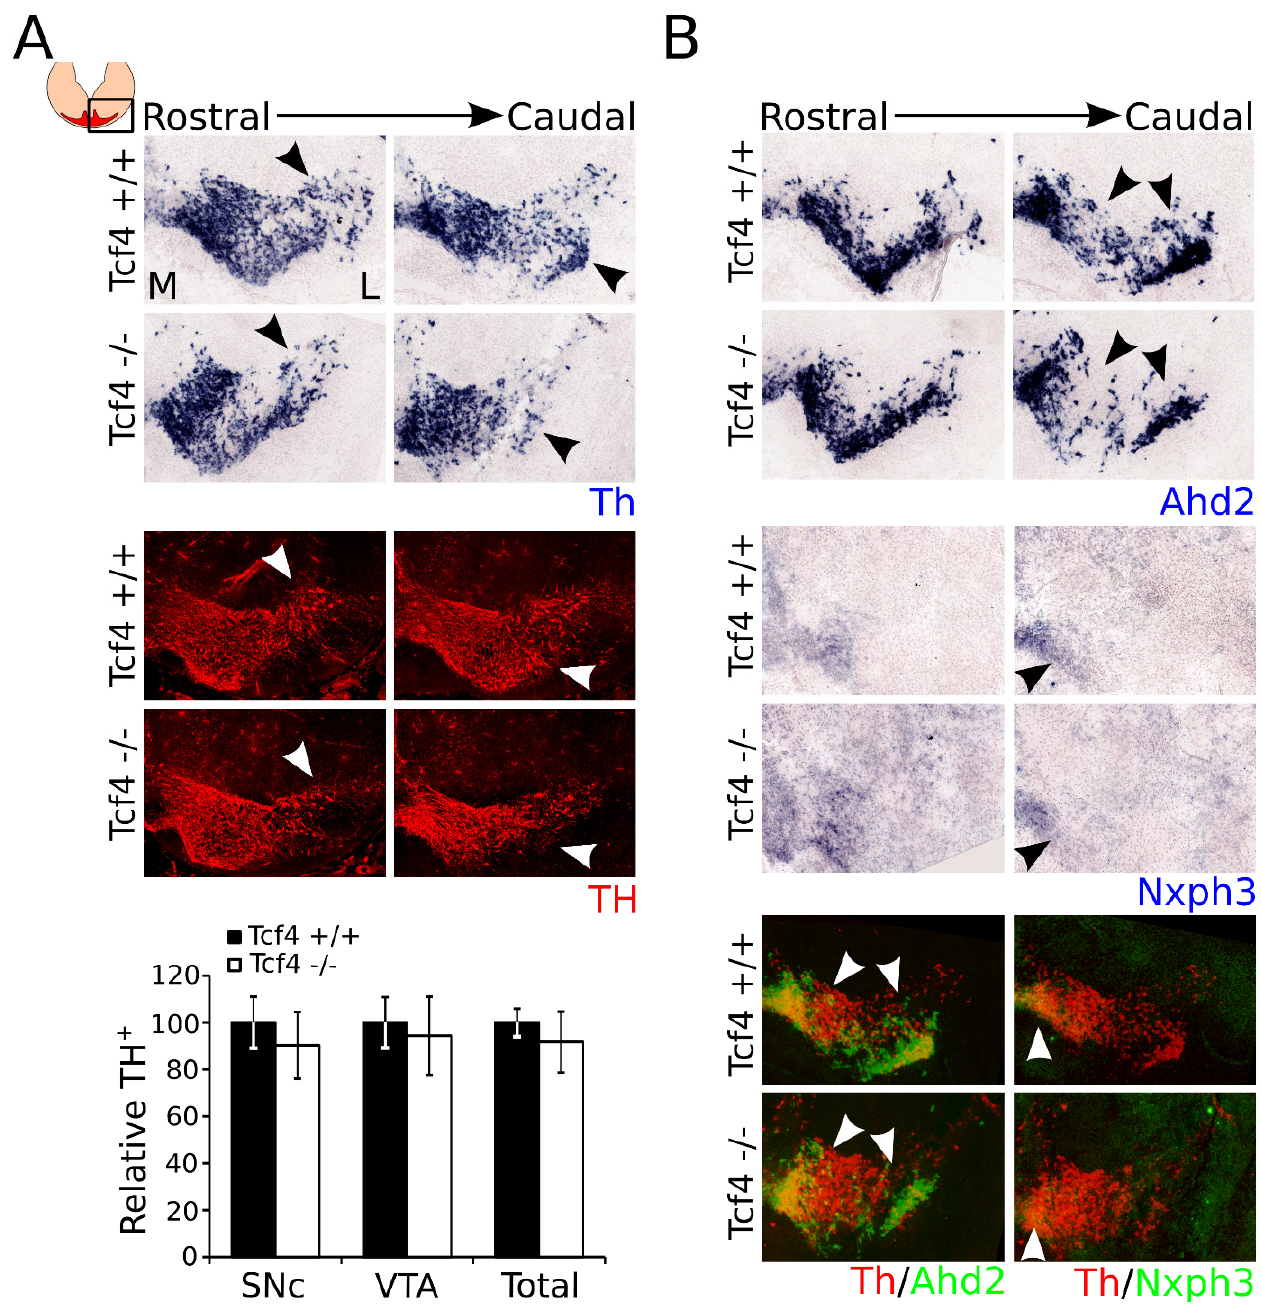
Figure 4. Expression of Th is affected in the mutant midbrain at P0, whereas the expression of Ahd2 and Nxph3 is partially recovered. ( A ) Expression of Th transcript (blue) in the mutant midbrain at P0 shows a decrease in the most lateral parts of the mdDA neuronal population (black arrowheads). Immunohistochemistry for TH-protein (red) shows a similar phenotype (white arrowheads). However, quantification of the TH-expressing neurons in the SNc, VTA, and the total population does not show a significant downregulation in the mutant (white bars) compared to the WT (black bars) (n = 3, two-tailed) M: medial, L: lateral. ( B ) Ahd2 (blue) expression is mostly recovered, but still shows a decrease in expression in the caudal regions of the mdDA neuronal population (black arrowheads). Nxph3 (blue) expression is similarly mostly recovered, but still shows a decrease in expression in the caudal regions of the mdDA neuronal population (black arrowheads). Pseudo-overlays of adjacent sections of Th (red) with Ahd2 (green) and Nxph3 (green) shows that the expression of Ahd2 and Nxph3 coincides with the expression of Th , and the affected areas are similar between the different markers (white arrowheads).